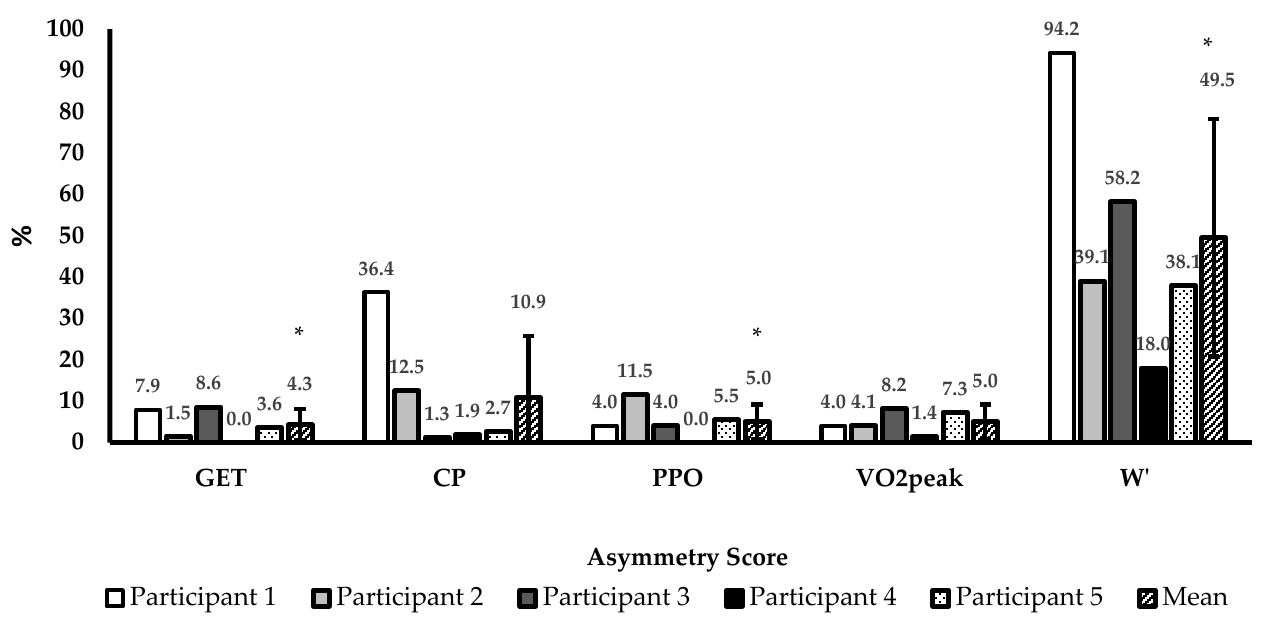
Figure 1. Individual and mean asymmetry scores at gas exchange threshold, critical power, and peak power output. Mean asymmetry scores presented as mean and standard deviation. * = statistically significantly different from 10%.